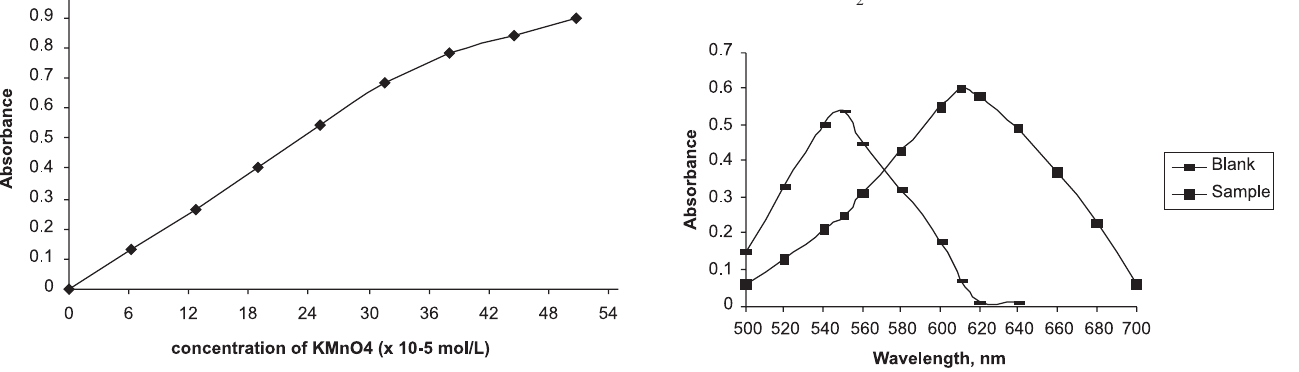
FIGURE 7 - Absorption spectra for method B. (Bluish green color produced for 27.18 x 10 -6 mol/L SMT